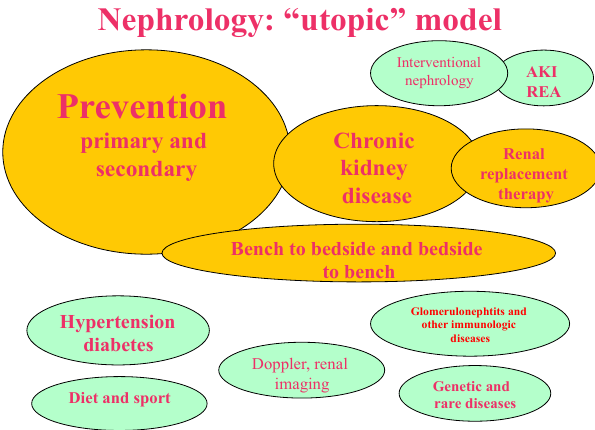
Figure 3. The “holistic” or “comprehensive” model: the focus is on a comprehensive system, in which all aspects of care and research are included.